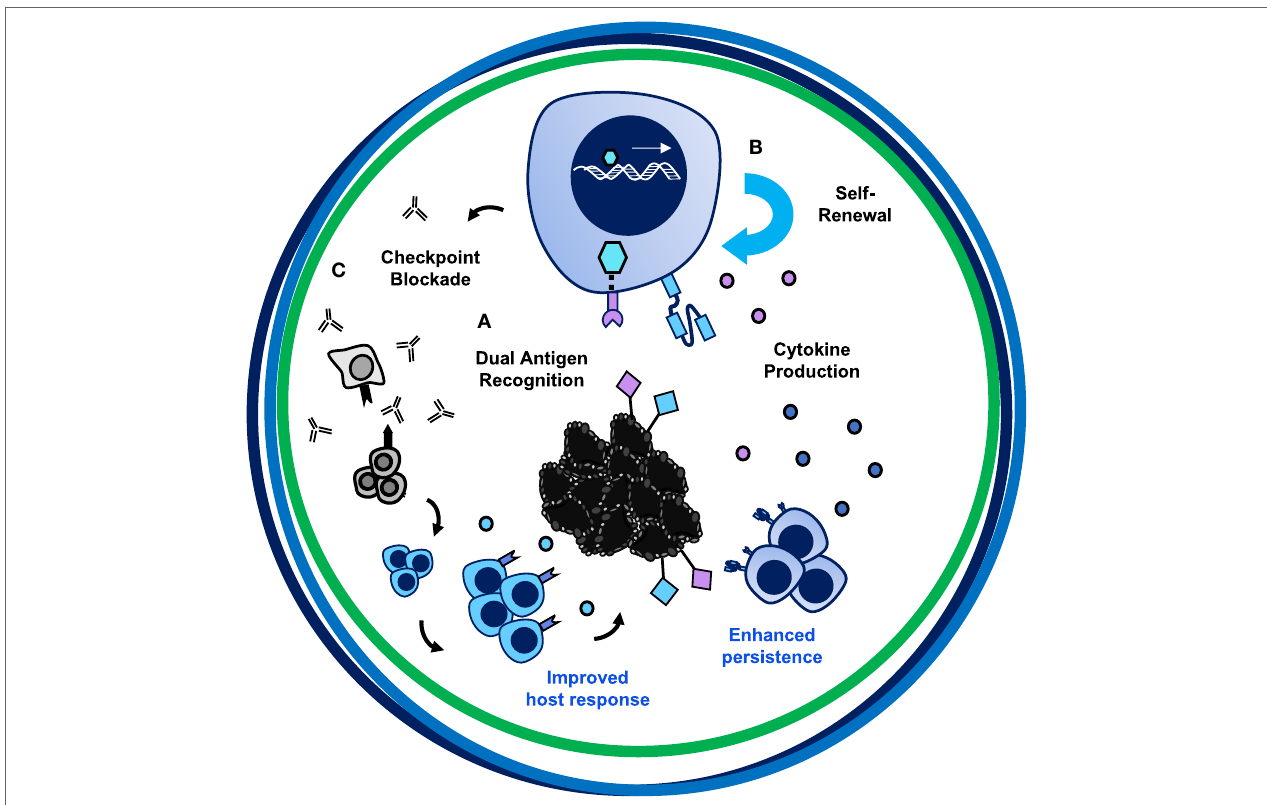
FigURe 7 | The trifecta of successful chimeric antigen receptor (CAR) T cell therapies in solid tumors. The ultimate CAR T cell therapy has tumor specificity, potent migratory capacity and persistence, and improves the host immune response. (A) Bispecificity through syn-Notch technology augments targeting to tumor/ tumor-specific tissue. (B) Engineering a T cell with enhanced persistence and migratory capacity—such as a Th17 or CD4 + CD26 high cell—or with self-renewing properties—such as a CD8 + T SCM cell—will enhance long-term memory responses to prevent tumor recurrence. (C) Secretion of PD-1 blockade and cytokines such as IL-12, IL-15, IL-18, or IL-21 locally could overcome the suppressive tumor microenvironment, reinvigorate the exhausted host immune response to other tumor antigens, and synergize with CAR-specific T cells to destroy large heterogenous solid